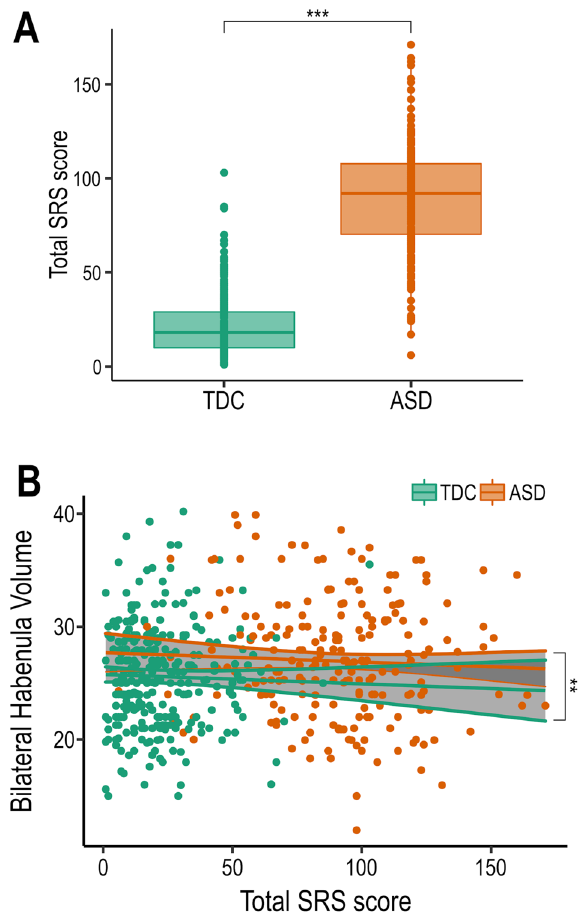
Figure 3. ( A ) Main effect of diagnosis on SRS score. ( B ) No significant interaction of Habenula volume and SRS score in either group. ** indicates p ≤ 0.01; *** indicates p ≤ 0.001. SD: autism spectrum disorder subjects; TDC: Typically developing controls.